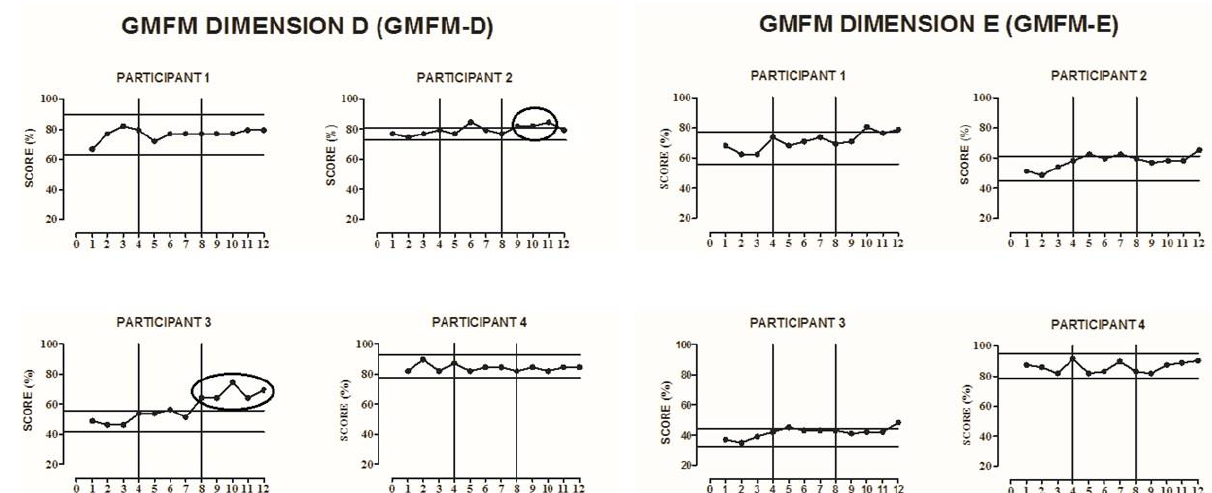
Figure 2. Visual representation of the Gross Motor Function Measure—Dimensions D and E at baseline, intervention, and follow-up phases for participants 1, 2, 3, and 4 ( P1 – P4 ). The solid horizontal lines indicate ± 2 standard deviations from the mean of the baseline data. The x-axis represents the phases A–B-follow up, and the vertical lines divide the phases. The circles that encompass data show a change trend after a graphic visual inspection of the baseline.